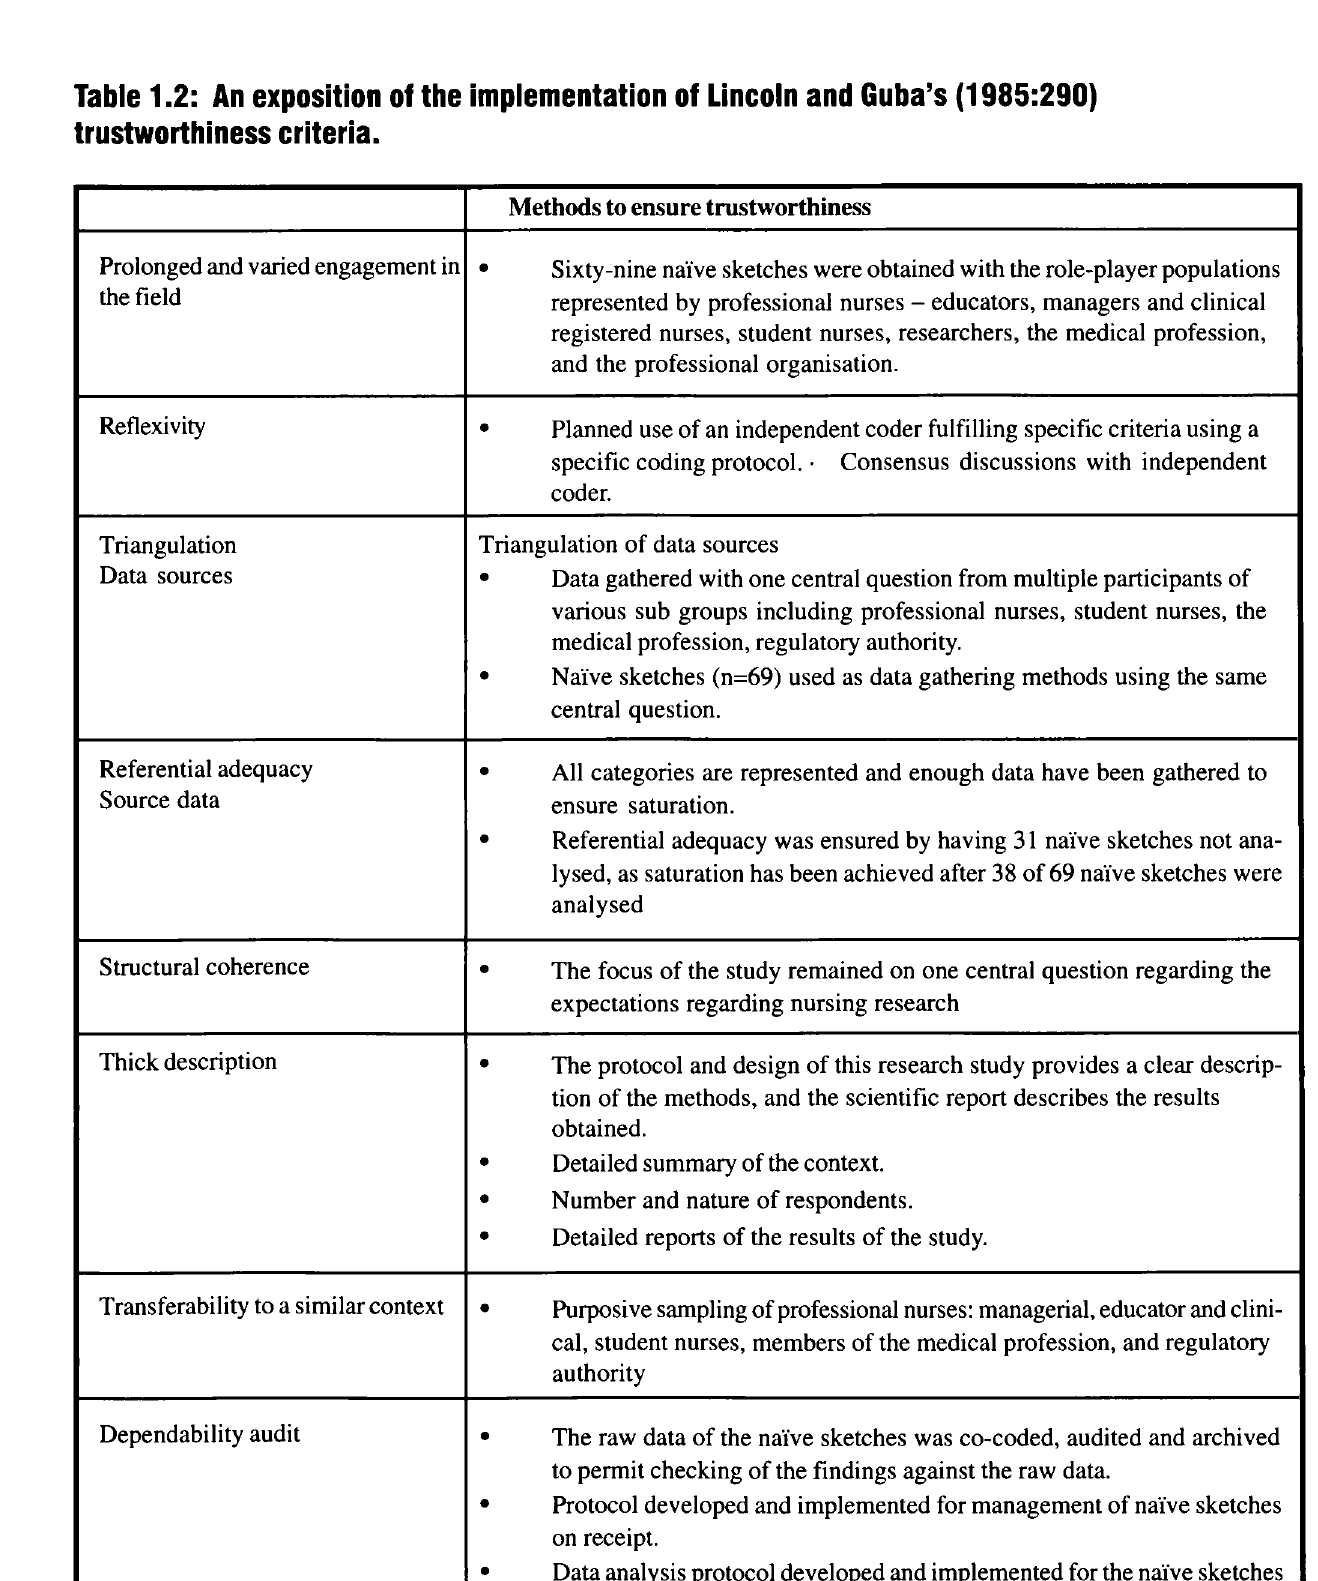
Table 1 .2 : An exposition of the implementation of Lincoln and Guba’s (1985:290) trustworthiness